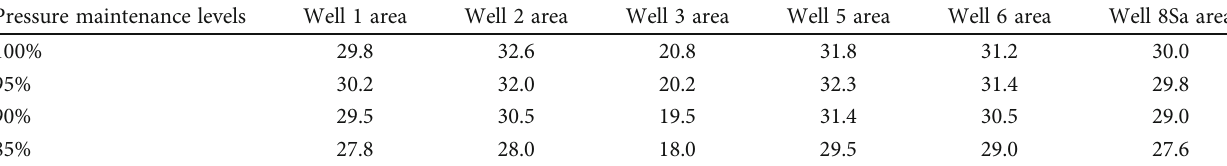
Figure 10: Production curve of A24, B12, A23, and B14. Table 2: Comparison table of oil recovery under di ff erent pressure maintenance levels in di ff erent well